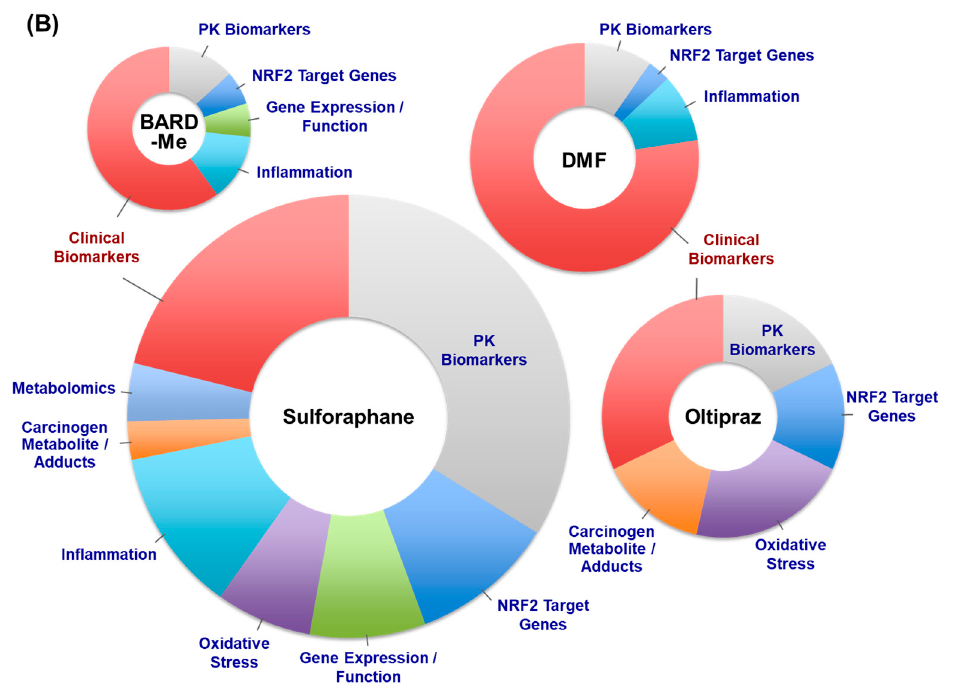
Figure 2. ( A ) Classification of biomarkers used in published clinical studies of “NRF2 Inducers”. ( B ) Distribution of biomarker categories used in the clinical studies. The size of each pie reflects the total number of times a biomarker of each class was used in the clinical studies. Multiple classes of biomarkers were used in some studies. PK, pharmacokinetics.